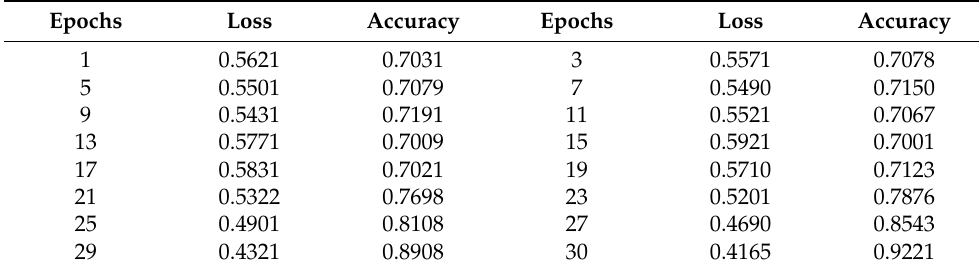
Table 6. The performance of CNN Performance at the time of training.